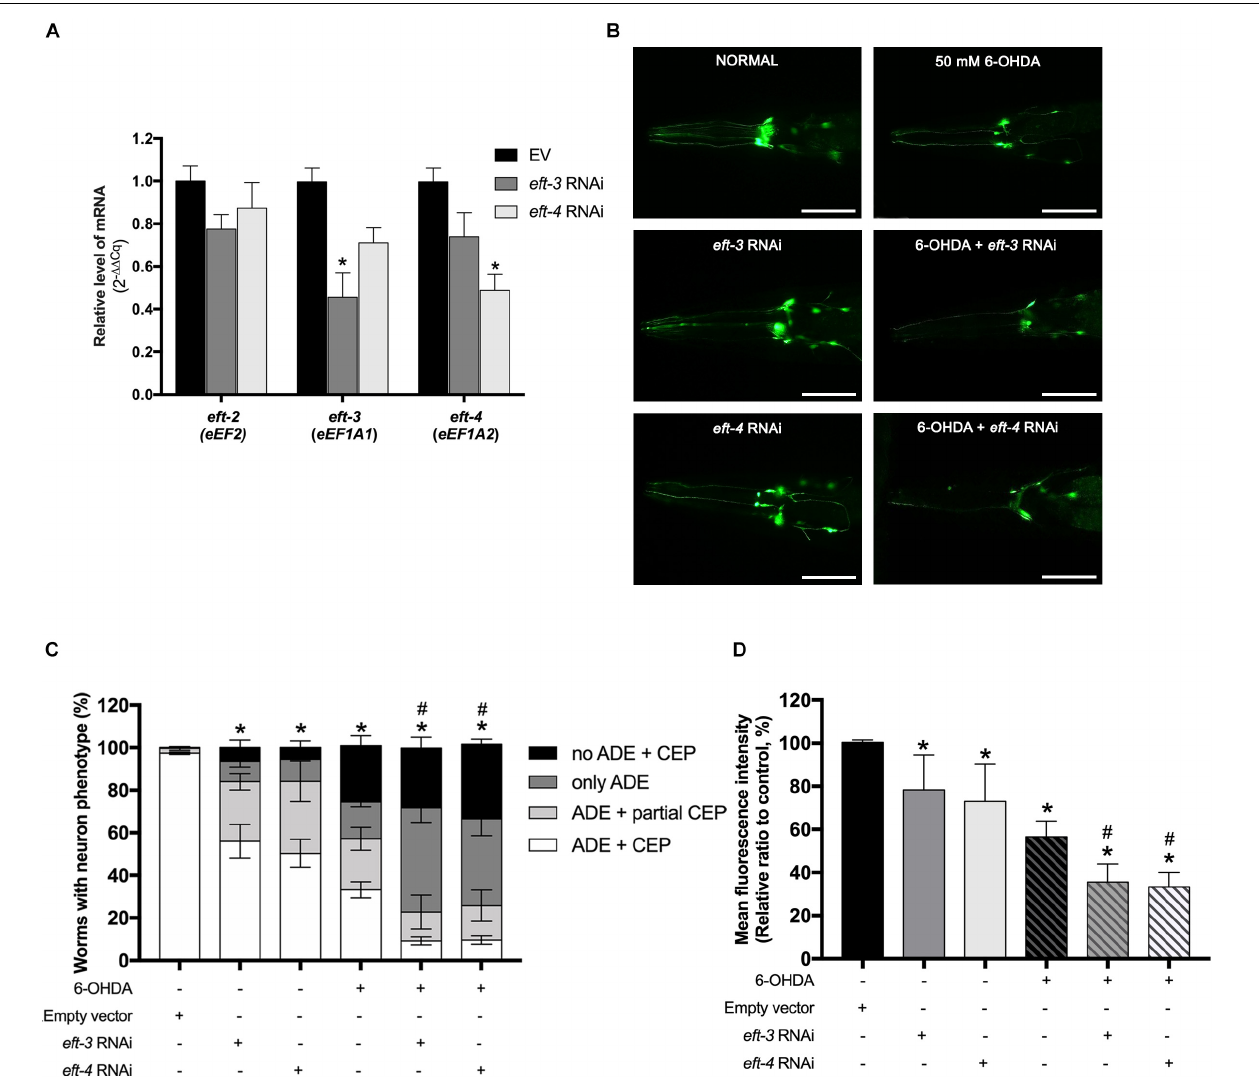
FIGURE 2 | Effects of eft-3 / eft-4 RNA interference (RNAi) and/or 6-hydroxydopamine (6-OHDA) exposure on the dopaminergic (DA) neurons in Caenorhabditis elegans. (A) Fold change of mRNA expression levels of eft-3 and eft-4 between empty vector (EV) RNAi and eft-3 or eft-4 RNAi-treated worms to ensure specific knockdown. The asterisk (*) indicates a significant difference between the EV RNAi and eft-3 or eft-4 RNAi-treated worms ( p < 0.05). (B) Green fluorescent protein (GFP) expression pattern in DA neurons of normal UA202 strain, eft-3 / eft-4 RNAi-treated, 6-OHDA-treated, and co-treatment between eft-3/eft-4 RNAi and 6-OHDA-treated worms. Scale bar, 50 µ m. (C) Graphical representation for percentage of DA neurons phenotype worms. The asterisk (*) indicates a significant difference of percent worm with normal ADE + CEP phenotype between EV RNAi-treated and eft-3/eft-4 RNAi and/or 6-OHDA-treated worms ( p < 0.05). The hash (#) indicates a significant difference of percent worms carrying normal ADE + CEP phenotype between only 6-OHDA-treated and combined 6-OHDA and RNAi-treated worms ( p < 0.05). (D) Graphical representation for mean fluorescence intensity (MFI) of GFP expression in DA neurons as measured by using ImageJ software. The asterisk (*) indicates a significant difference between the EV RNAi-treated and eft-3/eft-4 RNAi and/or 6-OHDA-treated worms ( p < 0.05). The hash (#) indicates the significant difference between only 6-OHDA-treated and combined 6-OHDA with eft-3 or eft-4 RNAi-treated worms ( p <